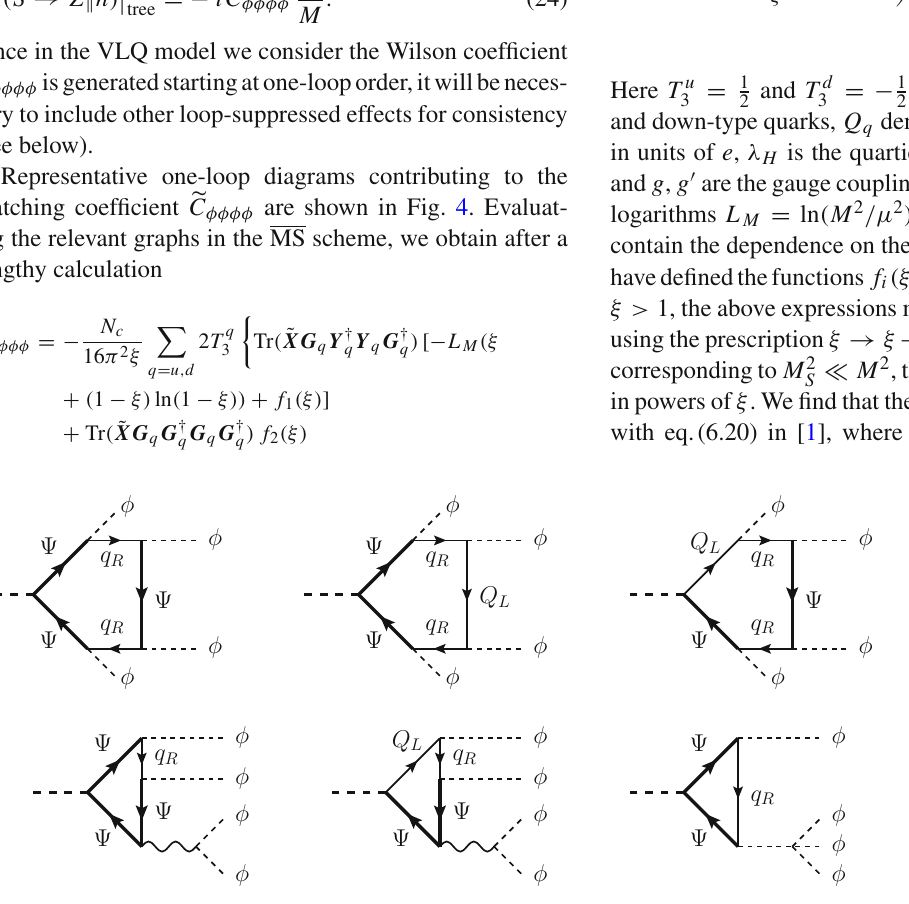
Fig. 4 Example diagrams contributing to the matching of the Wilson coefficient (cid:4) C